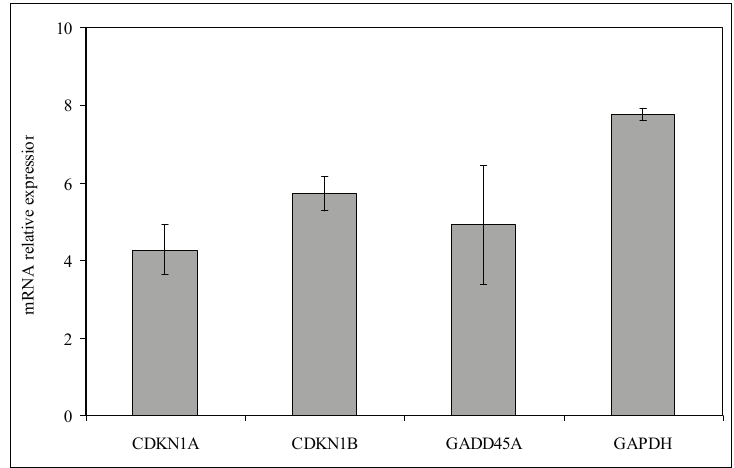
Figure 2. Effect of Dexamethasone on cyclin-dependent kinase inhibitor 1A ( CDKN1A) , cyclin-dependent kinase inhibitor 1B ( CDKN1B) , growth arrest and DNA-damage 45A ( GADD45A) and glyceraldehyde 3-phosphate dehydrogenase ( GAPDH ) and expression. RTqPCR analysis was performed in control and experimental SUP-T1 cells collected after 24 h from Dex treatment. GAPDH has long been used as a default reference gene in quantitative mRNA profiling experiments; however, since its expression varied in cancer as for many other genes, was preferred absolute quantification and untreated SUP-T1 cells were used for C T comparison [28]. In ordinate, mRNA relative expression = mRNA of treated cells/mRNA of controls. Data are expressed as the mean ± S.D. of 3 independent experiments performed in three PCR replicates.